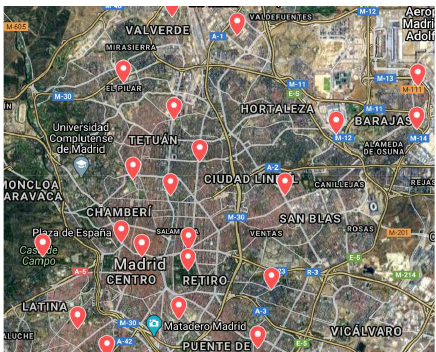
Figure 2. Air pollution sensors in Madrid.